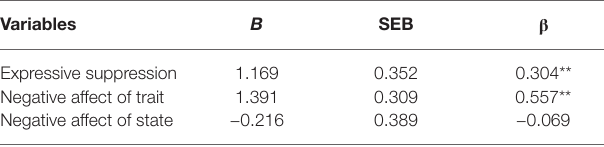
TABLE 6 | Standard regression analysis summary for psoriasis patients’ variables predicting emotion